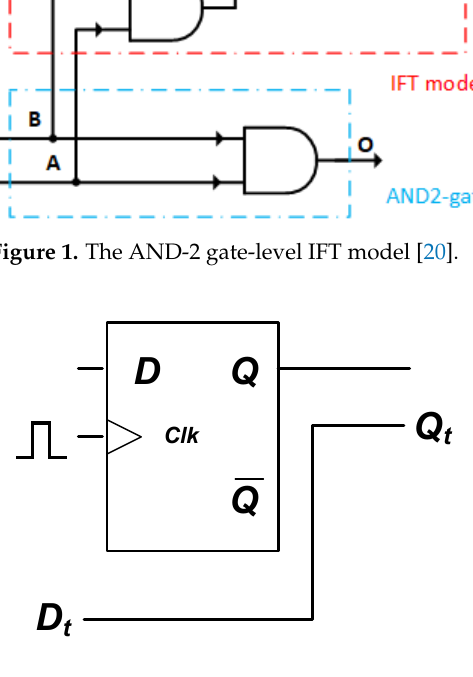
Figure 2. The DFF IFT